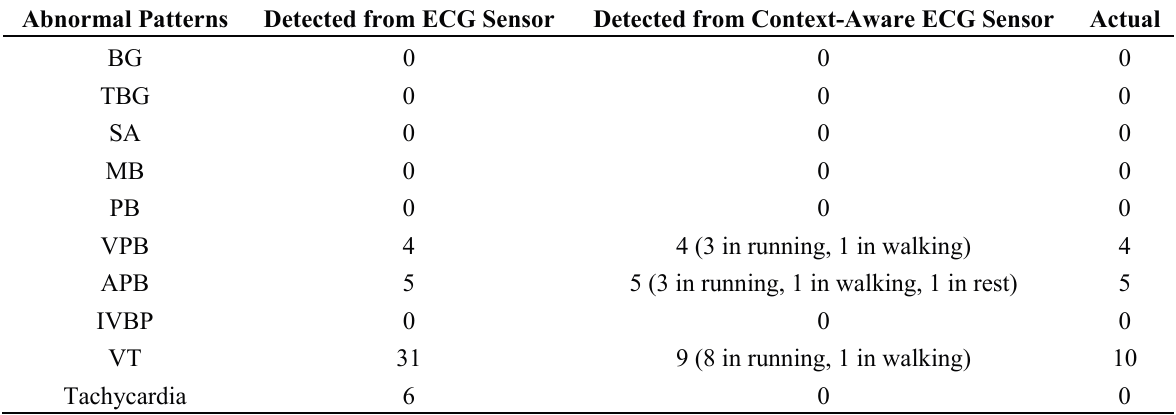
Table 11. Statistical analysis on the performance of proposed context-aware ECG system. Abnormal Patterns